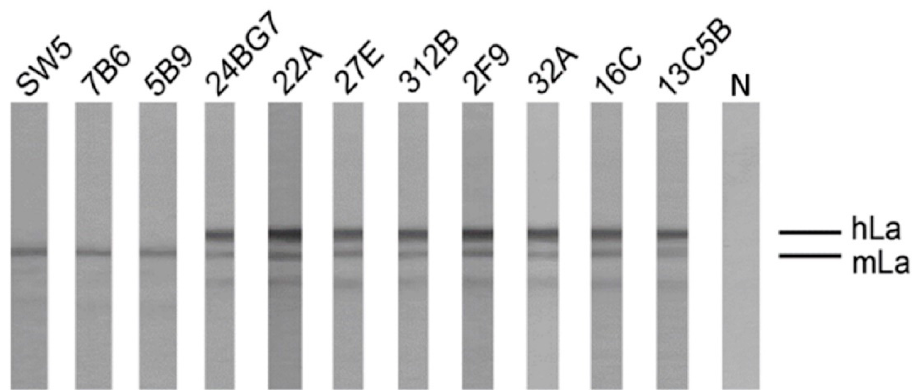
Figure 2. Origin of novel hybridomas. In order to rule out that the anti-La hybridomas, described here, are derived from adoptively co-transferred B cells of the immunized non-transgenic mice, the hybridomas were analyzed for the presence of human La protein using SDS-PAGE and immunoblotting. For this purpose, total extracts of the anti-La hybridoma cells including the previously established and well characterized conventional anti-La hybridomas (SW5, 7B6, and 5B9) and in addition the isolated anti-Ro hybridoma (312G) were prepared and blotted against the anti-La mab (5B9) which recognizes a cryptic epitope present in both human (hLa) and murine La protein (mLa). The secondary ab served as negative control (N).